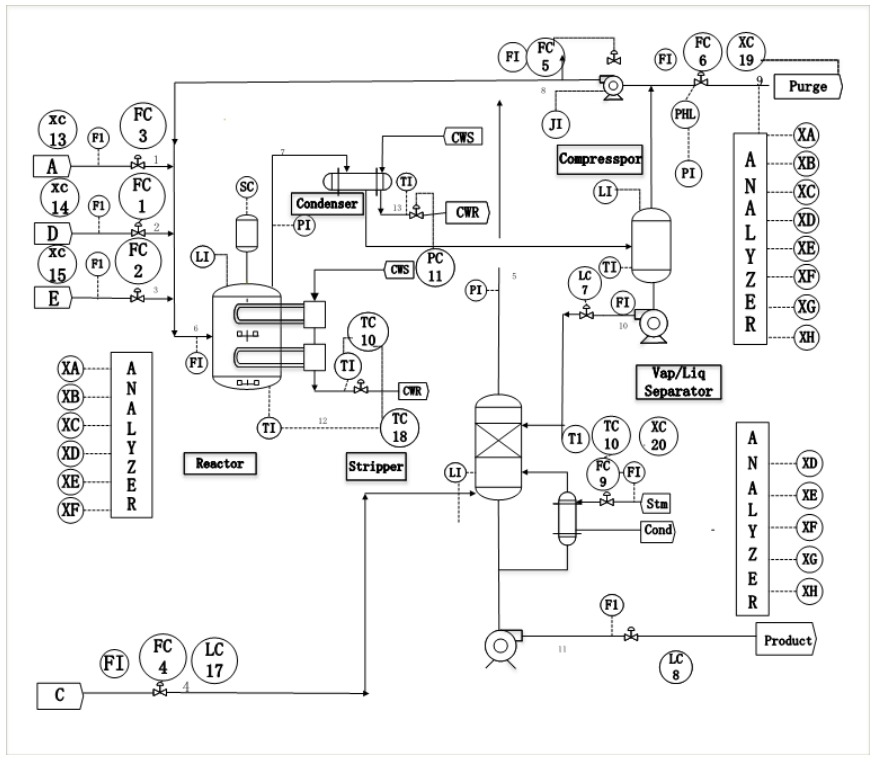
Figure 4. The Tennessee Eastman process